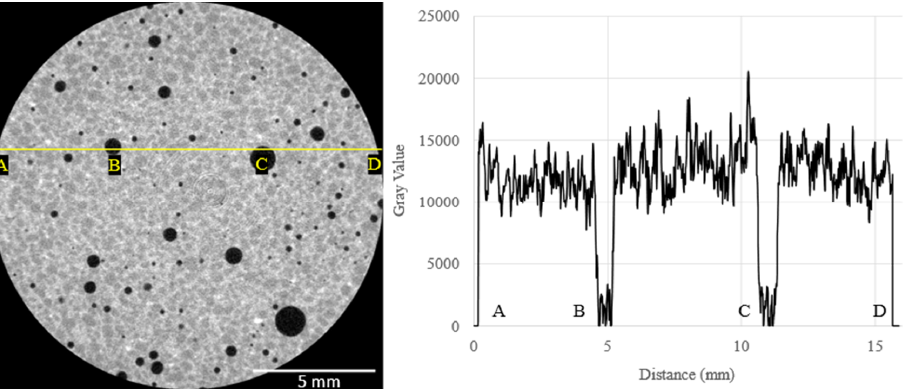
Figure 8. The left image is a 2D reconstructed cross-section of a neat concrete specimen. The right image is the corresponding line profile of grayscale values intensity values based on scale from 0 (black pixel value) to 65, 535 (white pixel value) identifying key microstructure within the concrete mix design designated by points ( A – D ). ( B , C ) both show porous or air void regions spatially and their corresponding grayscale values.